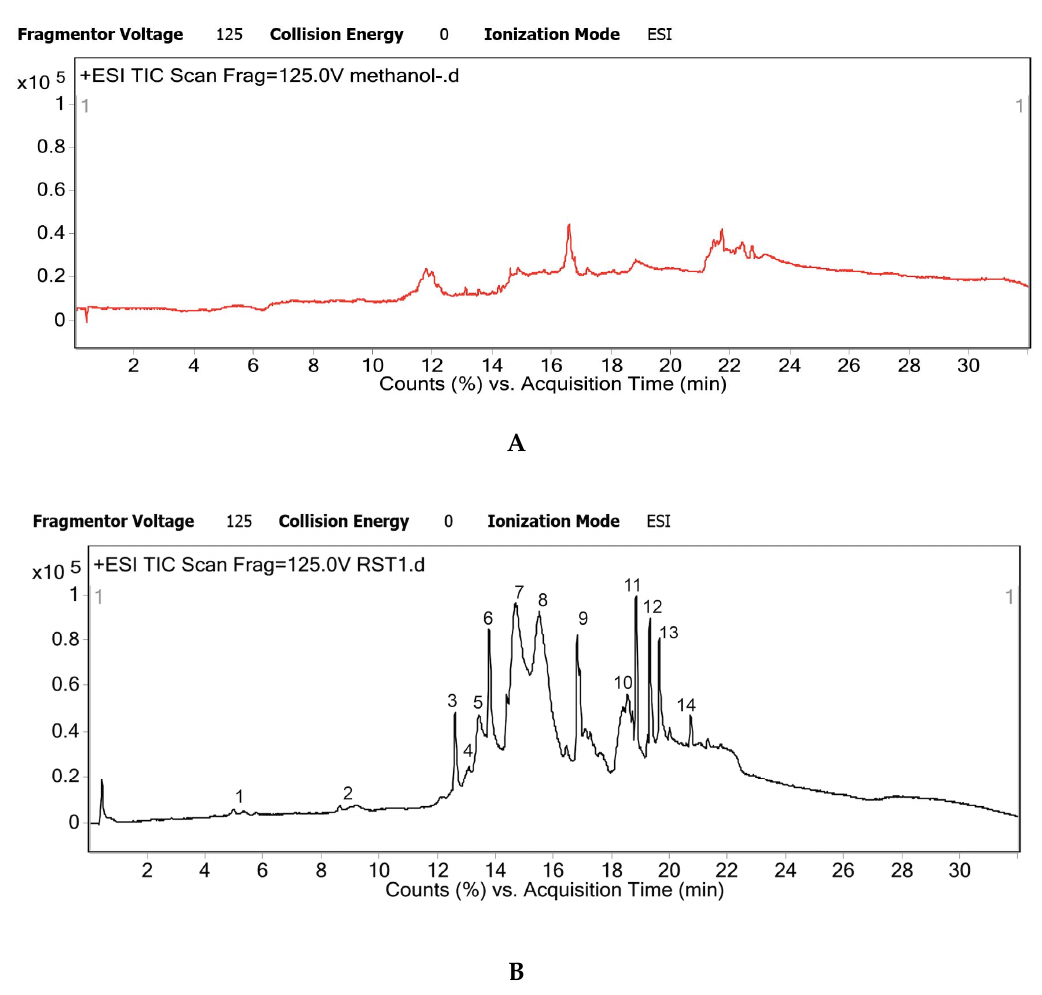
Figure 1. Total ion chromatogram generated by Agilent 6520 UHPLC-QTOF instrument and mass hunter software; ( A ) methanol blank chromatogram; ( B ) Hydroalcoholic root extract of R. serepentina chromatogram, n = 4 individual LCMS runs.